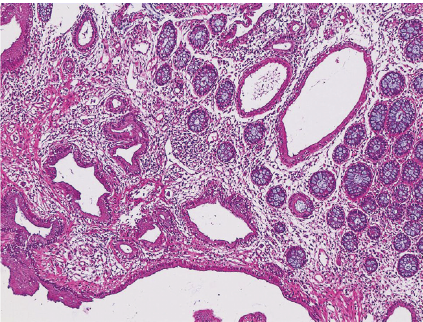
Figure 1: Microscopic image of the biopsy, stained with H&E, taken from fundus greater curvature by the use of gastroscopy. There is a well-di ff erentiated adenocarcinoma infiltration forming irregular tubular structures in gastric mucosa (H&E, × 100).